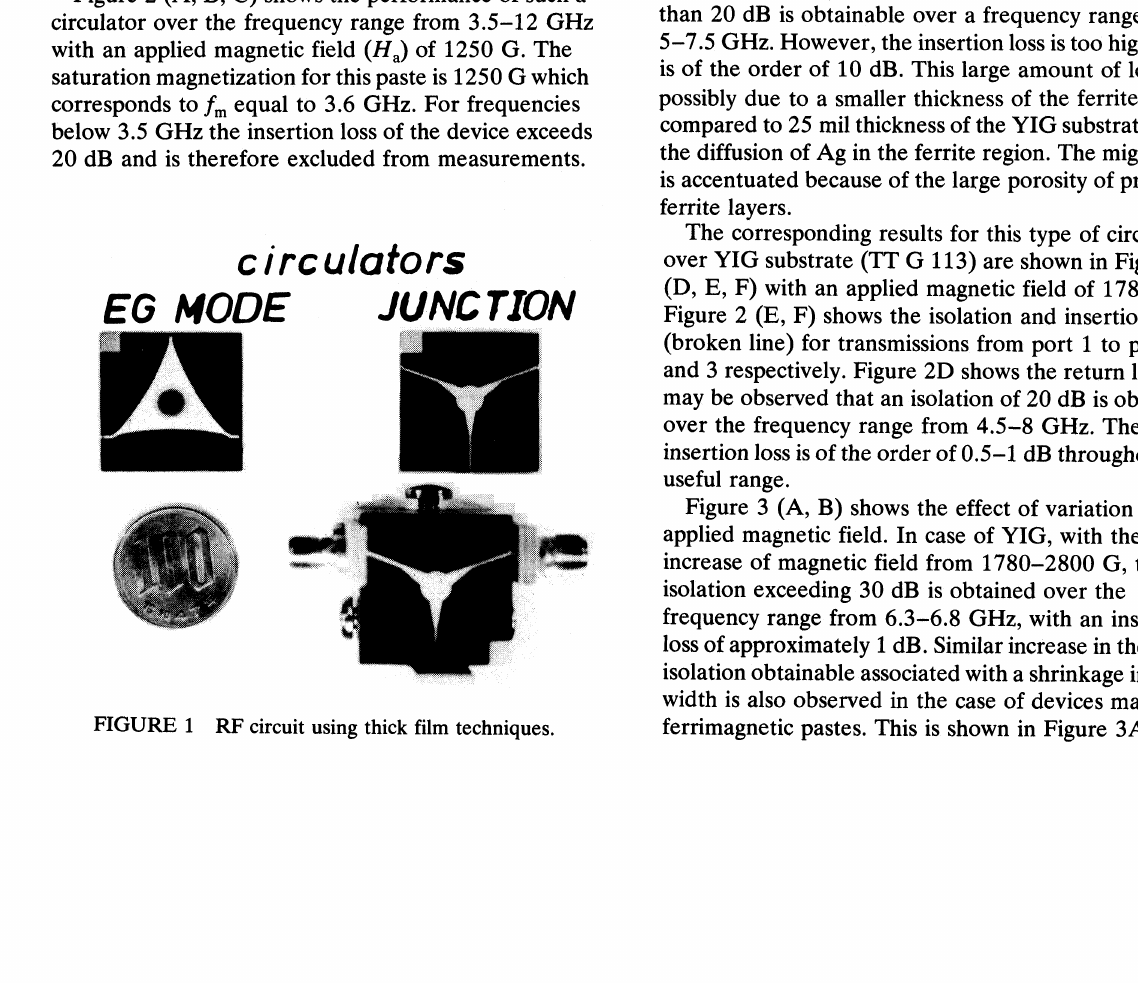
FIGURE 2 Composite diagram showing EGW circulator